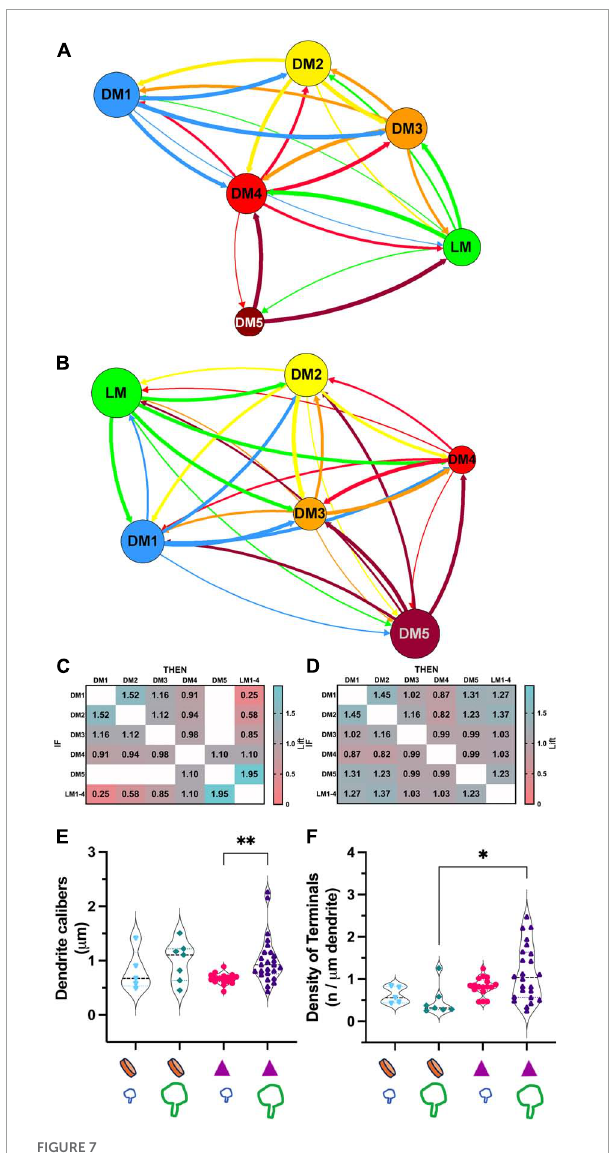
FIGURE7 Association analysis reveals the segregation of retinal and corticothalamic boutons on relay dendrites that form triads. (A) The network analysis for outstrength associations among each bouton type that synapse on dendrite segments of X-type relay arbors. All retinal boutons (green- LM) are grouped; the bouton groups with dark or no mitochondria are marked following the same color scheme in Figure 5 (DM1-5). The line thickness indicates the strength of association from one terminal type to another type; arrows indicate the direction of the association. Corticothalamic (DM1, blue) and retinal (LM, green) boutons are strongly associated with all other bouton types but not with each other. (B) Network analysis for outstrength associations among each bouton type that synapse on dendrite segments of Y-type relay arbors. Retinal boutons are strongly associated with all other bouton types except for the largest DNM boutons (DM5). Corticothalamic boutons (DM1) are most strongly associated with DM2, DM3 and DM4 type boutons, putative GABAergic and brainstem cholinergic inputs. (C) Lift values from the association rules analysis for X-type relay dendrite segments. Lift values indicate the probability that the occurrence of a type of bouton (IF rows) influences the occurrence of another type (THEN columns) on the same dendrite segment. A lift value greater than 1 indicates that the occurrence of an “IF” bouton has a positive effect on the occurrence of the “THEN” bouton. A lift value near 1 indicates that the occurrence of